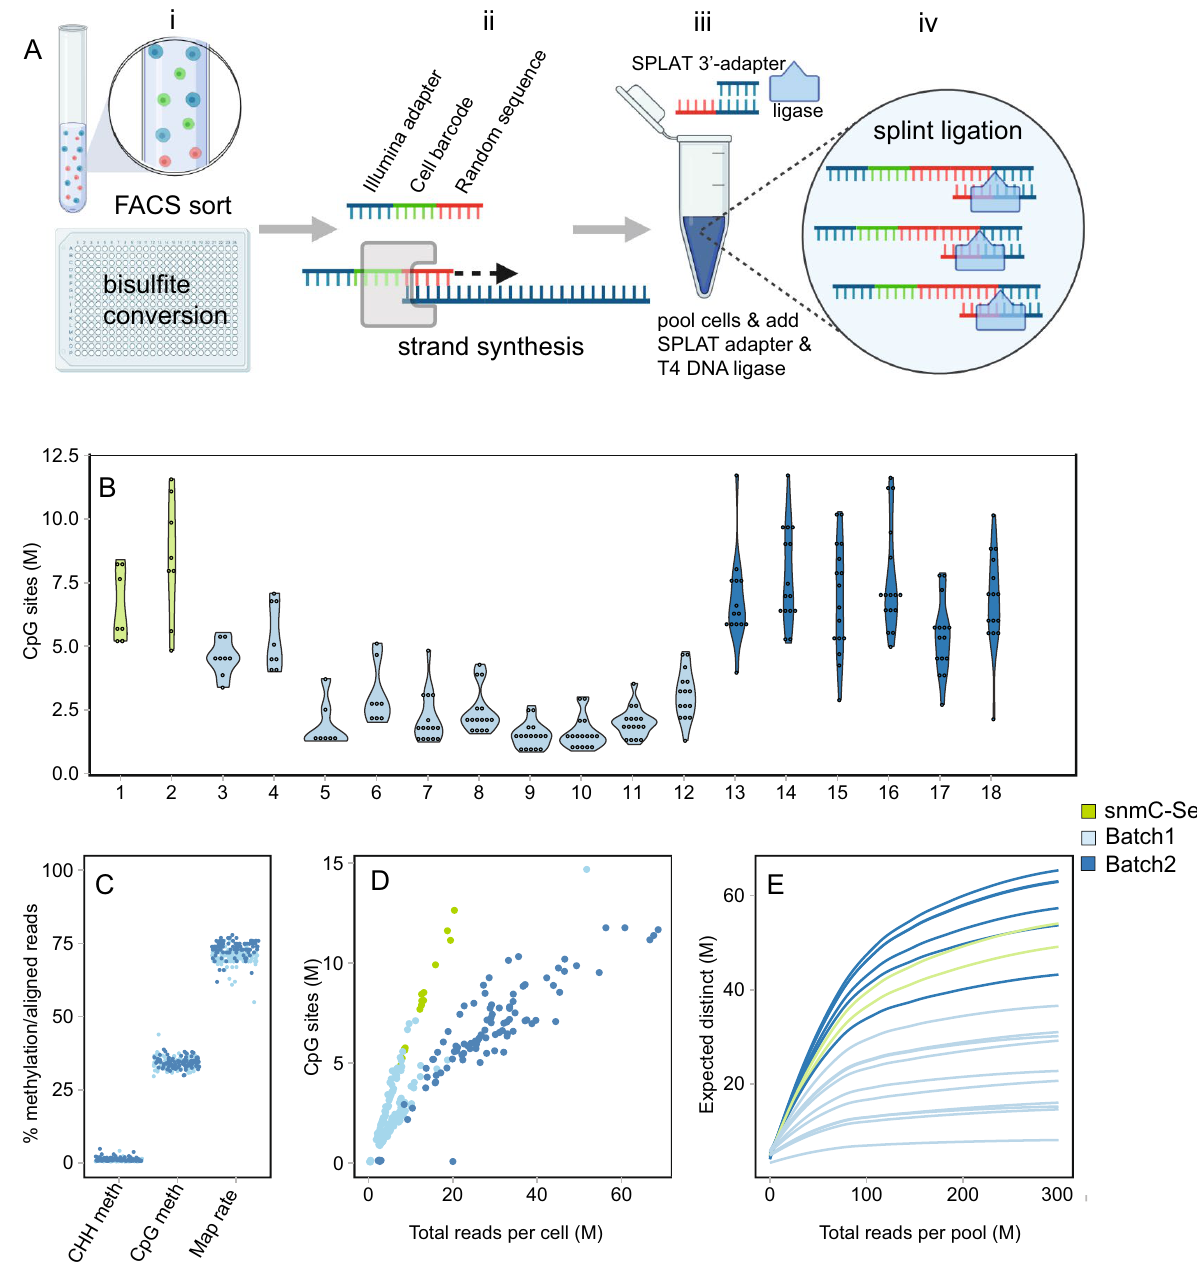
Figure 1. Schematic overview of the scSPLAT method and quality assessment of single cell K562 data. ( A ) Step i-iv. i) Cells are FACS sorted into 384 wells containing lysis buffer and bisulfite conversion is performed in 384- plate format. ii) A random strand synthesis reaction is performed in each well using a randomer flagged with an inline cell barcode and 26 bp of the Illumina P5 adapter sequence. iii) Reactions from multiple wells (up to 32) are then pooled and SPRI bead purified. iv) Splinted ligation adapter tagging (SPLAT) is performed to ligate the adapter to the 3’-ends of the DNA fragments in a bulk reaction. ( B ) Violin plots showing the total number of covered CpG sites/cell in each library pool. Individual cells are indicated by dots overlaying the plots. Violin plot number 1–6 comprises 8 cells and number 7–18 comprises 16 cells. ( C ) The percentage of CHH methylation (indicative of bisulfite conversion efficiency), methylation levels in CpG-context and read mapping efficiency per K562 cell. ( D ) The number of CpG sites per cell covered ≥ 1 × plotted as a function of the total number of (raw) reads generated per cell. ( E ) Pool-wise library complexities plotted with the c-curve function in the preseq